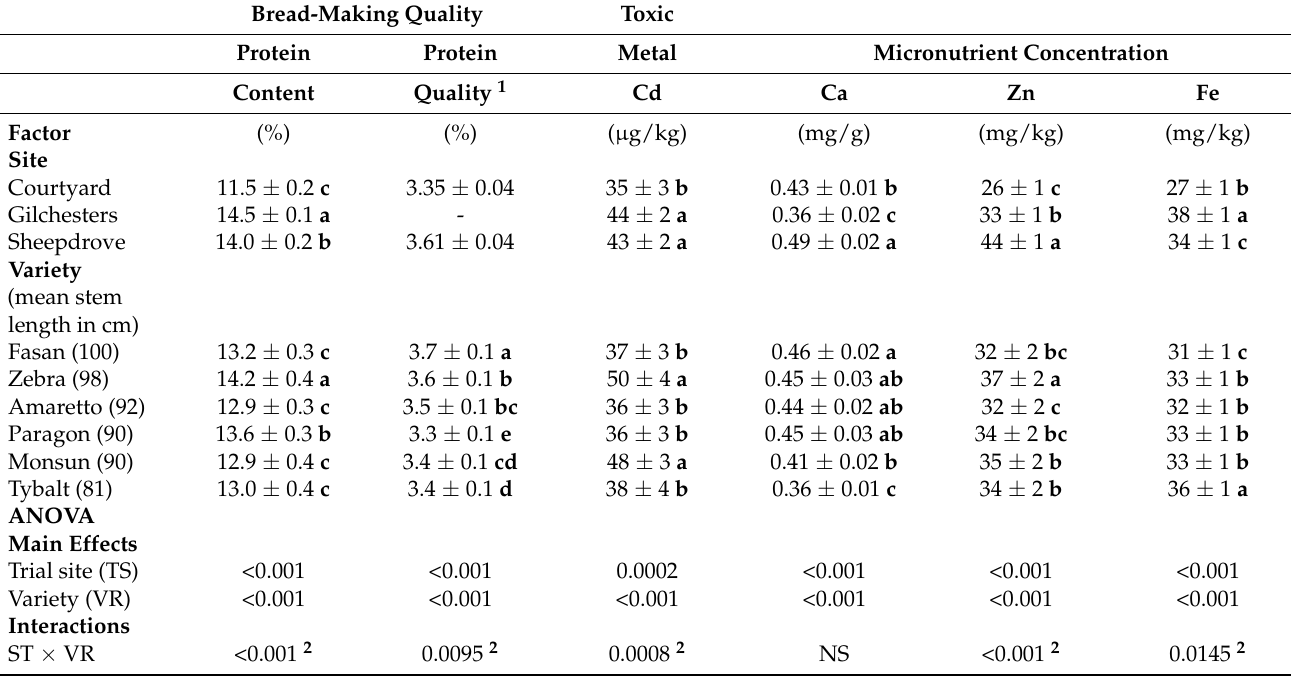
Table 7. Main effect means ± SE and ANOVA results ( p -values) for the effects of site (Courtyard farm, Norfolk, UK; Gilchester farm, Northumberland, UK; Sheepdrove farm, Berkshire, UK) and variety on selected processing and nutritional quality parameters in spring wheat ( T. aestivum ) grown under organic management regimes. Results shown are from a re-analysis of data previously published by Wilkinson [57].